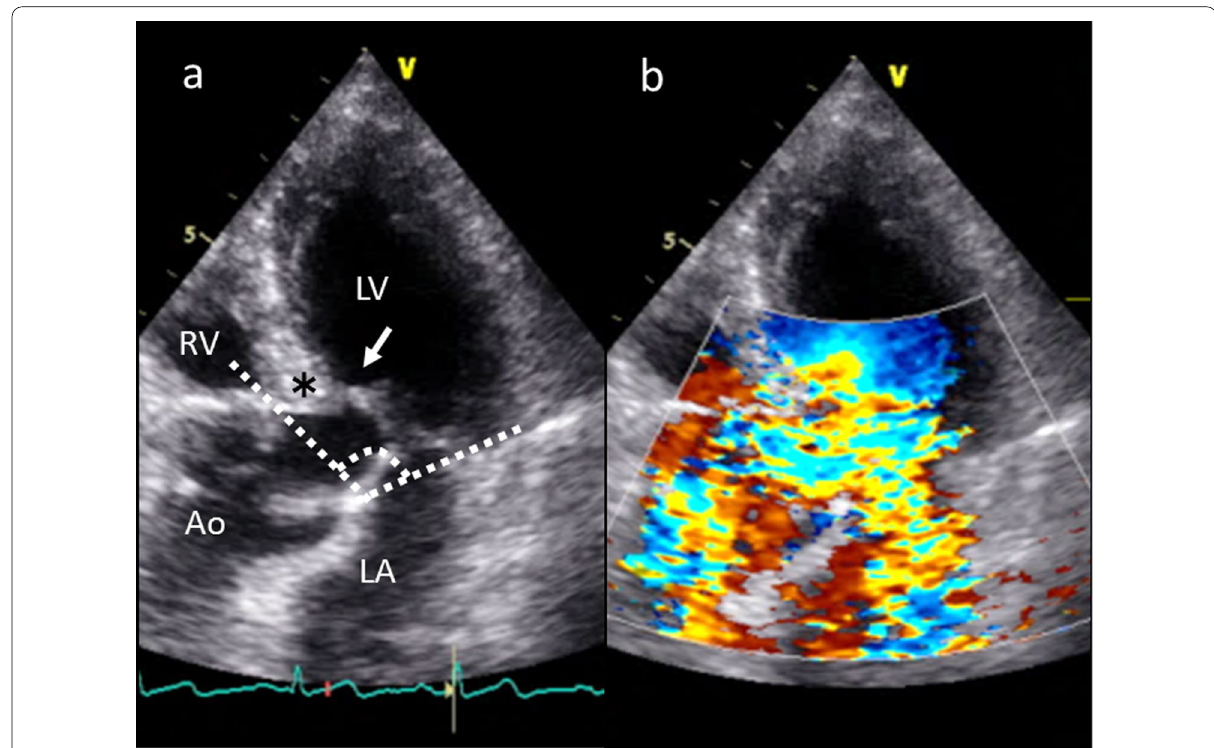
Fig. 2 Preoperative transthoracic echocardiographic views. a Left ventricular outflow tract obstruction with systolic anterior motion of the mitral valve (white arrow), thick basal interventricular septum, and septal bulging (black asterisk) due to narrow aorto-mitral angle (dotted lines). b Color Doppler imaging of mitral regurgitation and flow acceleration in the left ventricular outflow tract. Ao: aorta; LA: left atrium; LV: left ventricle; RV: right